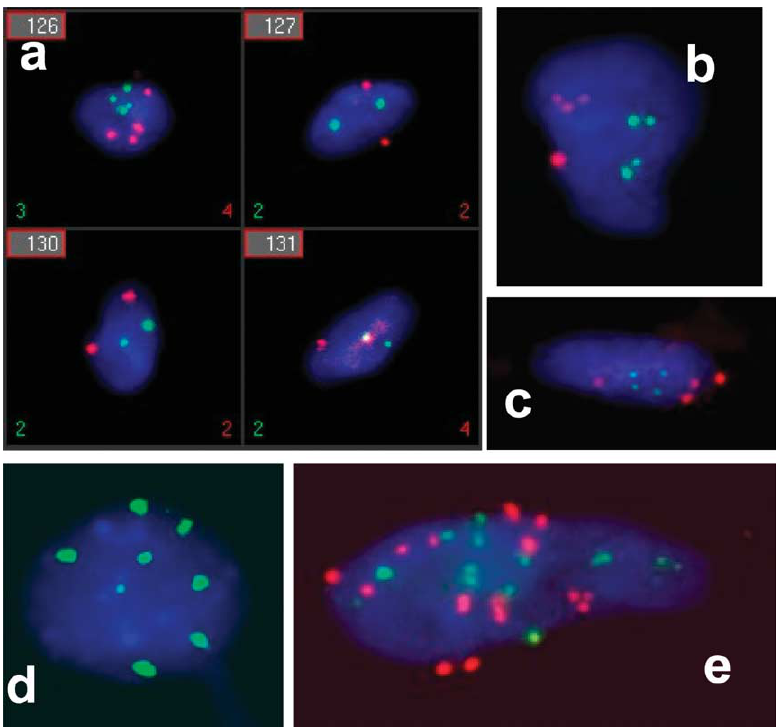
Fig. 4. FISH signals in ancient schwannoma displaying characteristic eusomic-polysomy. (a) Part of slideshow of Metafer 4 containing 3 disomic and one tetrasomic tumor cells. (b–c) Bizarre and ‘normal’ tumor cells with tetrasomy. (d) Octasomic tumor cells. (e) Enlarged tumor cell with 16 red and green signals. Some of red and green signals were out of focus when the picture was taken therefore they are not clearly visible. (a, b, c, e: Dual color FISH technique; red signals correspond to chromosome 18, green signals correspond to chromosome 17. (d): FISH technique; green signals correspond to chromosome